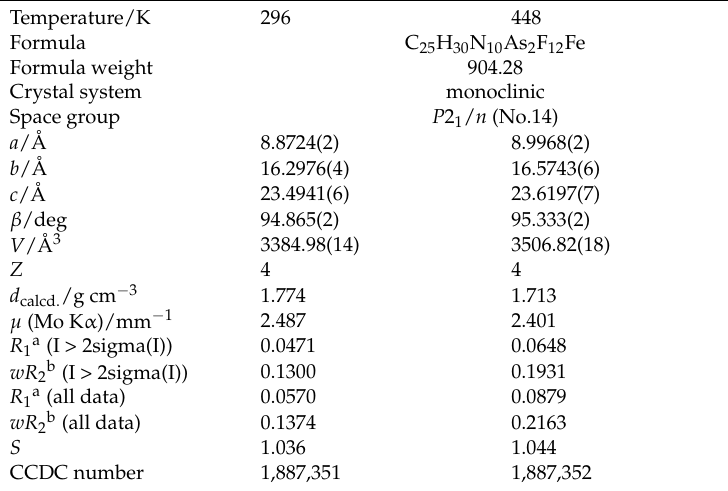
Table 1. X-ray crystallographic data for 1